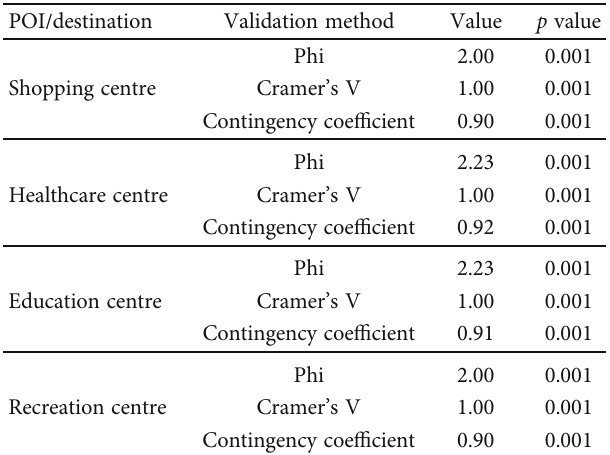
Table 6: Symmetric measure test